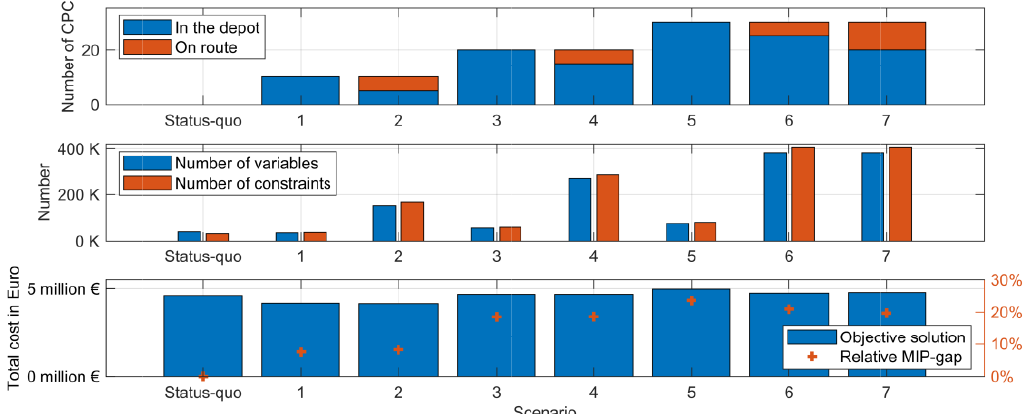
Figure 4. Comparison of the status-quo scenario and scenarios 1 to 7 with varying charging point candidates and the consequential implication for the problem size in terms of number of variables and constraints. The lower part displays the objective value after the optimization ( left ) and the relative mixed integer problem gap ( right ).